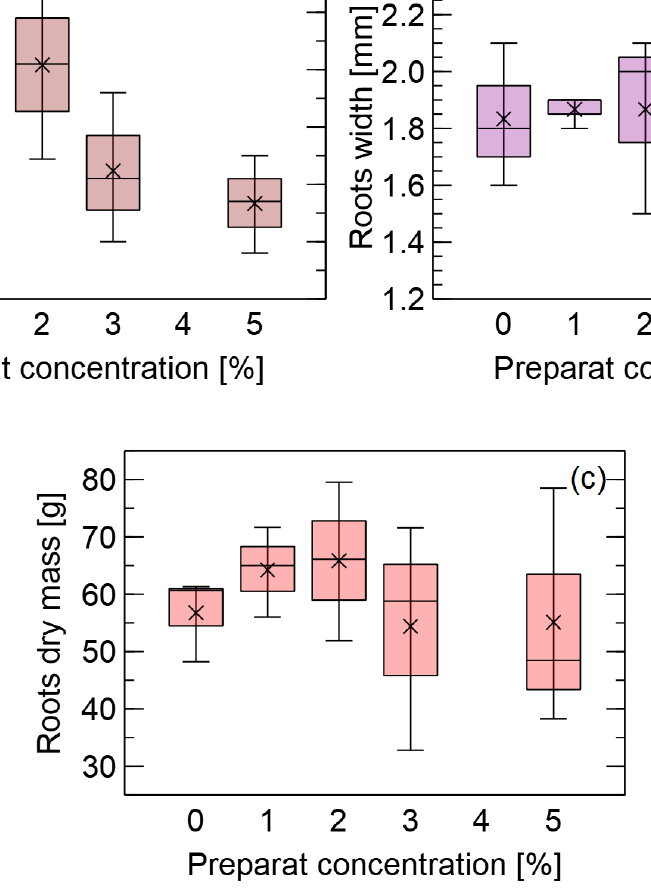
Figure 10. Oaks’ root length ( a ), width ( b ), and dry mass ( c ), versus silicon concentration, measured after finishing the experiment. The trends in the data were not found to be statistically significant at the p -value level of 0.05, thus, the regression fit lines are not plotted. In the plots, boxes span from the 1st to 3rd quantile, with the median indicated by a line, whiskers indicating a 1.5 inter-quantile range and the × symbol indicating the mean